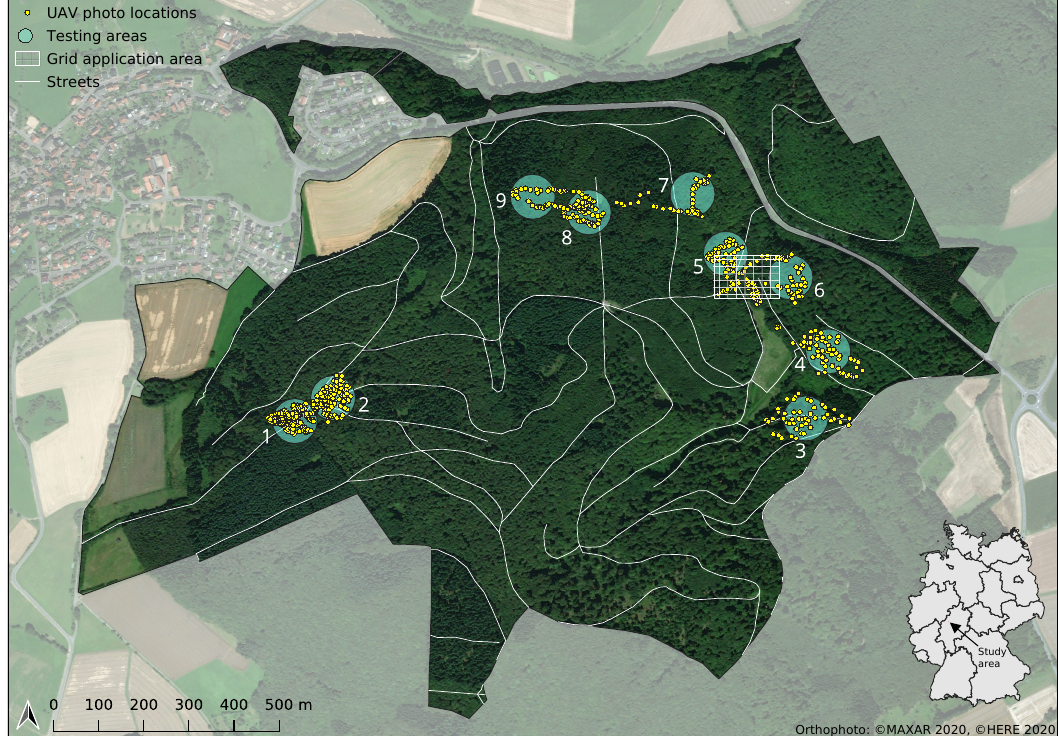
Study area: The Marburg Open Forest - Teaching and Research Forest of the Philipps-University of Marburg, State of Hesse, Germany. UAV photo locations of all conducted flight missions are denoted as yellow points. Testing areas 1 to 9 are delineated by cyan-colored circles. The area used for generating a gridded product is depicted as white raster